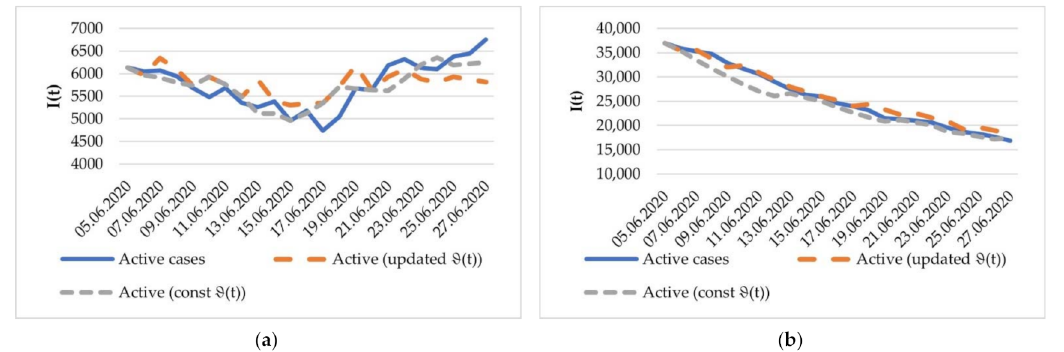
Figure 13. Dynamics of I ( t ) , the actual and modeled trajectories in the interval, from 6 June to 30 June 2020, in ( a ) Germany and ( b )